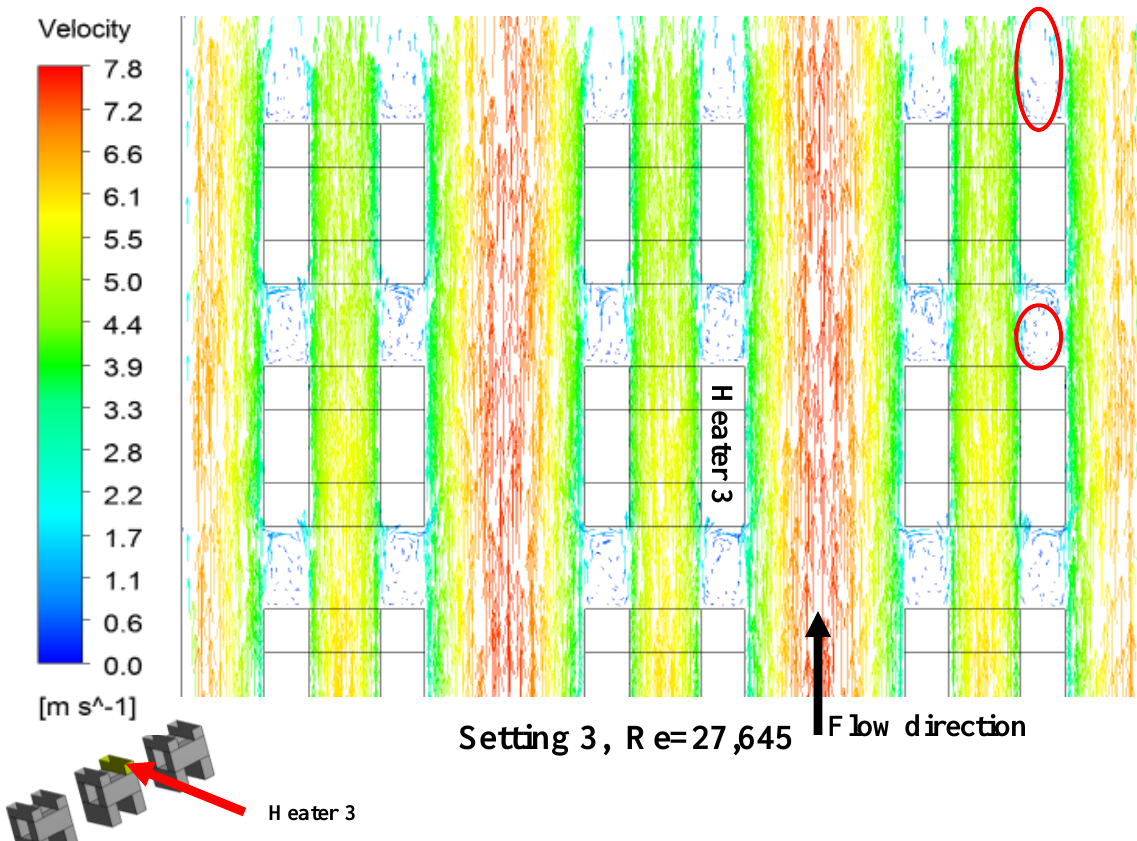
Figure 10. Velocity vectors in close-up view between fifth and sixth rows of a longitudinal plane passing through heater 3, Settings 2 and 3.